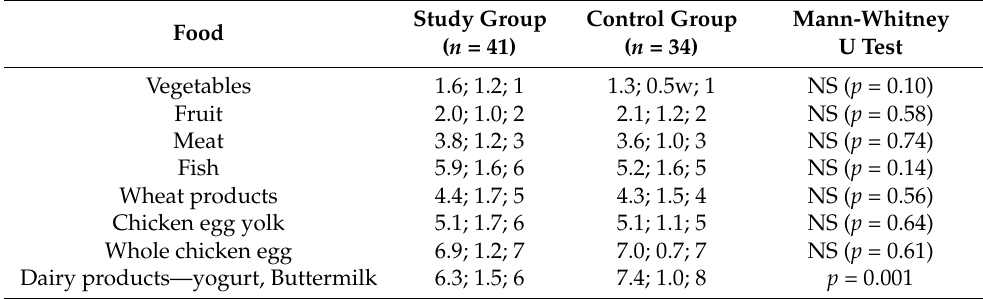
Table 4. The order in which particular foods are introduced as complementary foods in the study group and the control group (provided: mean; standard deviation; median) (question I/7).